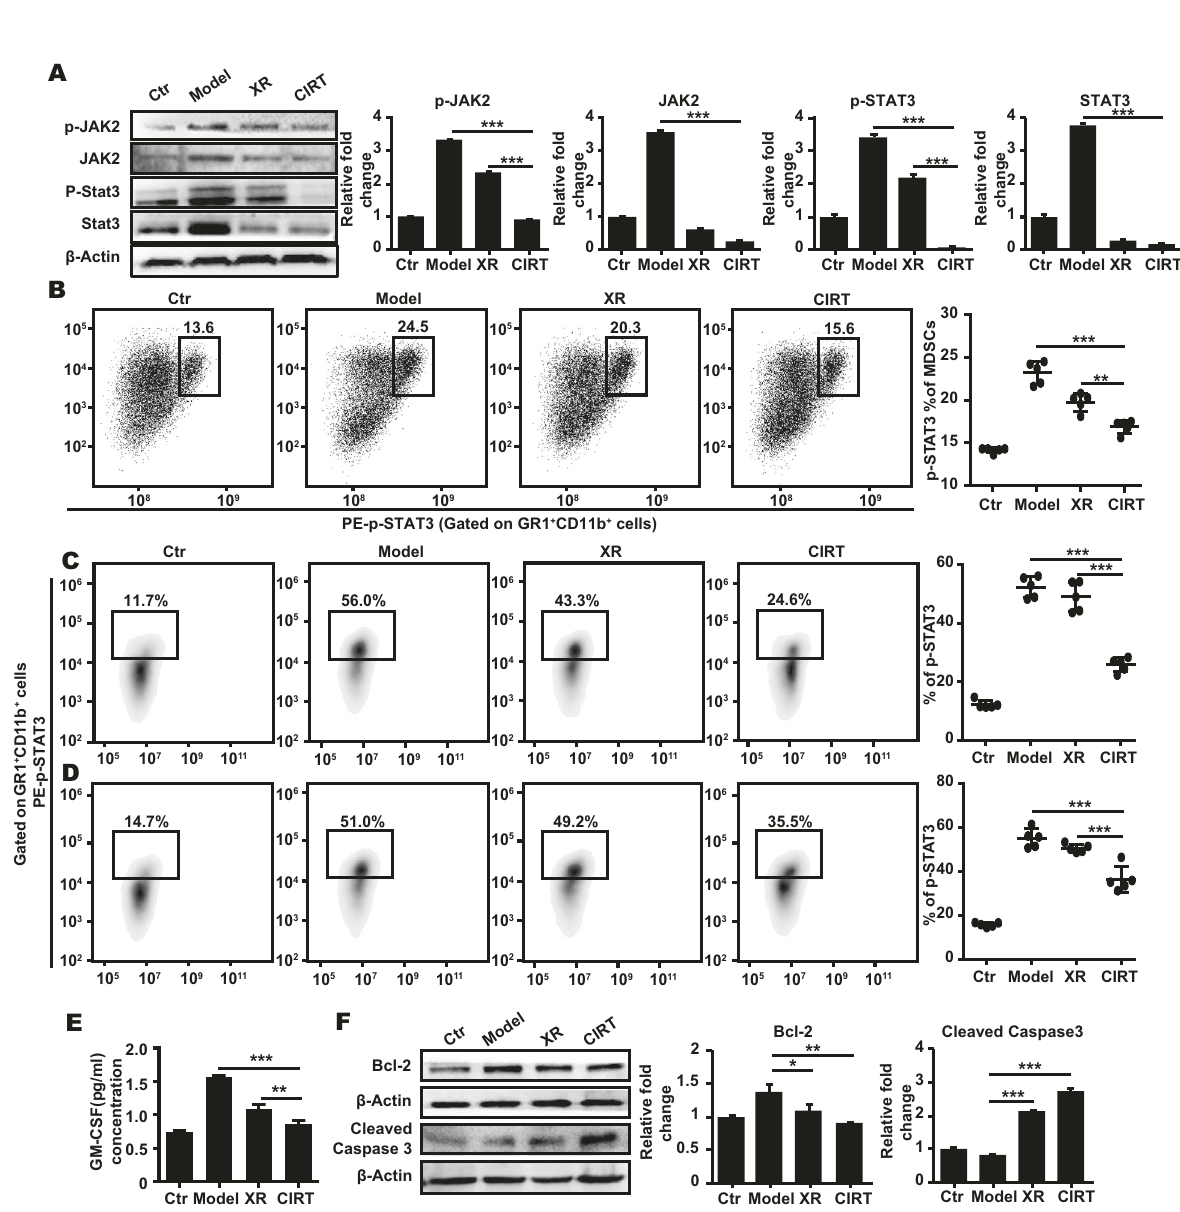
Fig. 2 The JAK2/STAT3 signalling is involved in the downregulation of MDSC. The C57BL/6 mice (Ctr) bearing subcutaneous melanoma (model) were locally irradiated with a dose of 5 GyE carbon ions (CIRT) on the tumour sites. On the 7 th day after irradiation, the bone marrow cells were collected and the MDSC were sorted by fl ow cytometry. Following the phosphorylation of JAK2 and STAT3 was detected using phosphoneoepitope-speci fi c antibodies using immunoblot or fl ow cytometry. Both p-JAK2 and p-STAT3 A , B were signi fi cantly decreased in the irradiated B16 melanoma-bearing mice. In the carbon ion radiation group, p-STAT3 decreased signi fi cantly both in MelanA C and S91 D melanoma-bearing mice. The GM-CSF was signi fi cantly decreased in the irradiated animals E , and the expression of the antiapoptotic protein, Bcl-2 was decreased whereas the abundance of cleaved caspase 3 was increased F , at the same time. Representative images and quanti fi cations are shown (mean ± SD of triplicate assessments, Student ’ s t -test, *** p < 0.001).